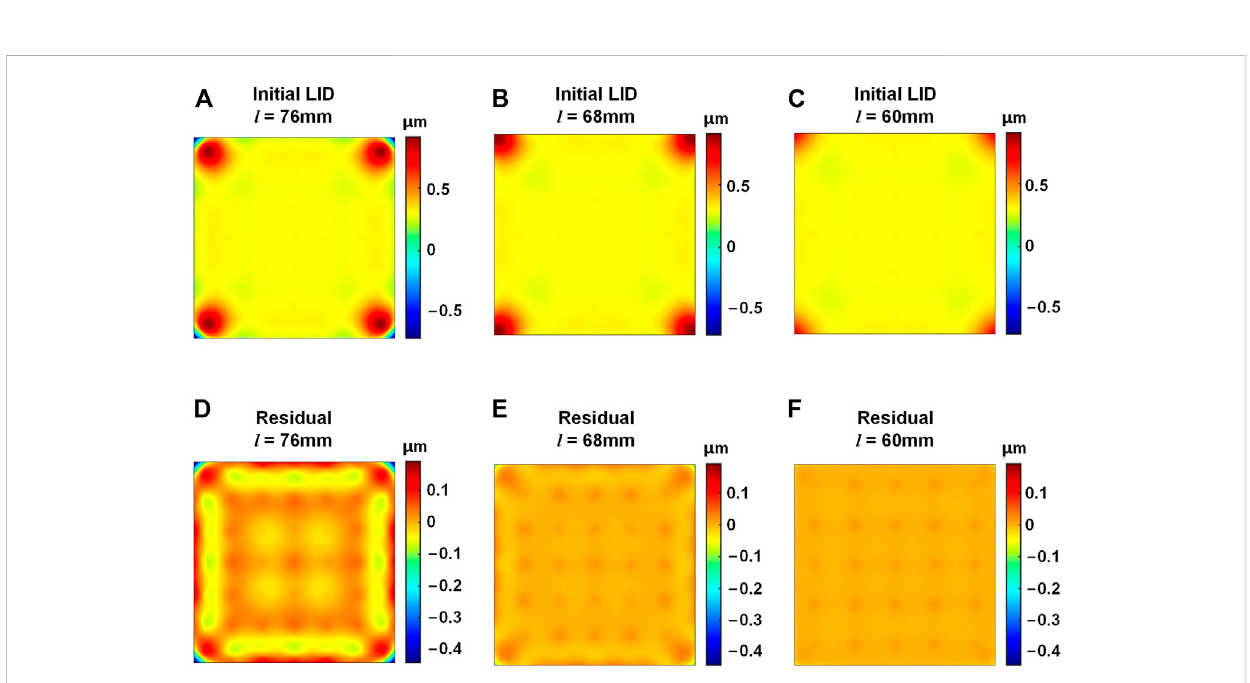
FIGURE 6 LIDoftheHDMwithdifferenteffectiveareasizes. (A – C) InitialLIDwiththeareasidelength l of76 mm,68 mm,and60 mm,respectively. ( D – F ) Self- correction residuals with the l of 76 mm, 68 mm, and 60 mm,